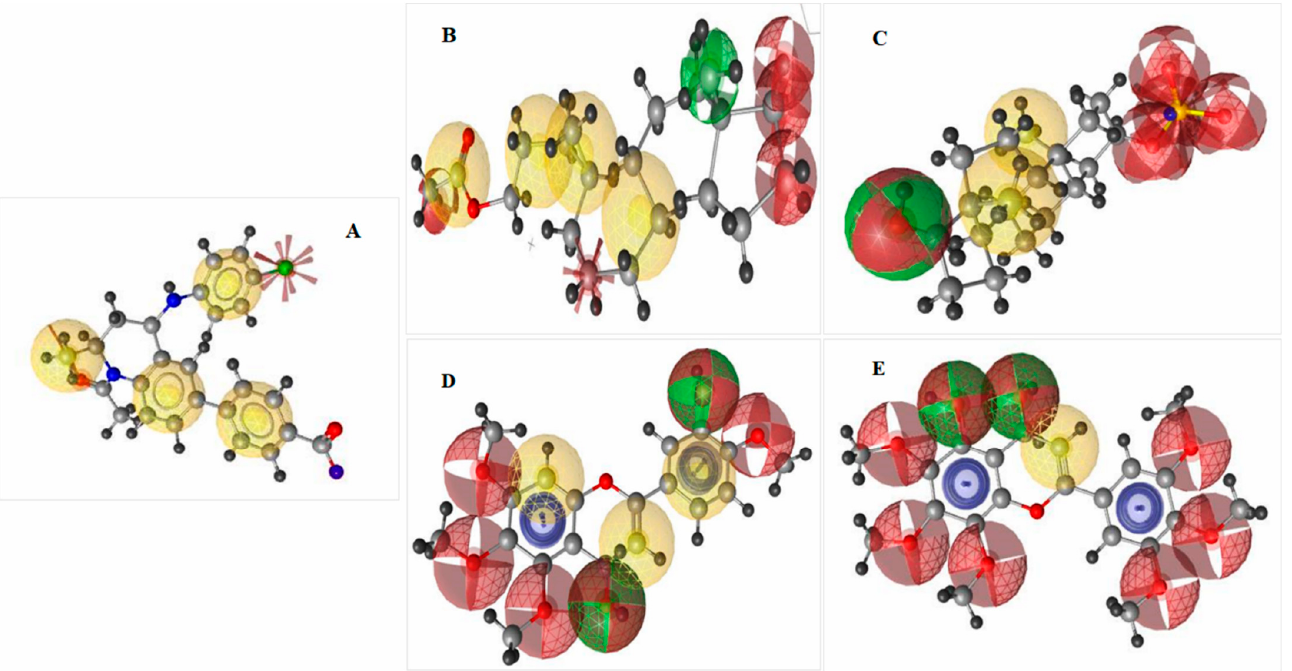
Figure 6. Pharmacophore feature analysis of four selected compounds with the target BRD4 protein. Herein, the figure representing ( A ) Query pharmacophore features and features generated from the attached ligand (ZINC95504909) with the selected protein Brd4 (PDB: 4BJX). The crystal structure generated four hydrophobic bonds (yellow), one negative ionizable group (red star), one H-bond acceptor (red), and one hydrophobic feature that shifted to a negative ionizable feature were detected. ( B ) ZINC2509501, ( C ) ZINC2566088, ( D ) ZINC1615112, and ( E ) ZINC4104882, the number of features was better than that for control ligand ZINC95504909 ( A ). Blue color indicated the presence of an aromatic ring among the selected ligand. Table 2. A list of different energy components and net MM/GBSA binding free energy (kcal/mol) and standard deviation values generated from the docking poses of the selected four compounds, including the control ligand